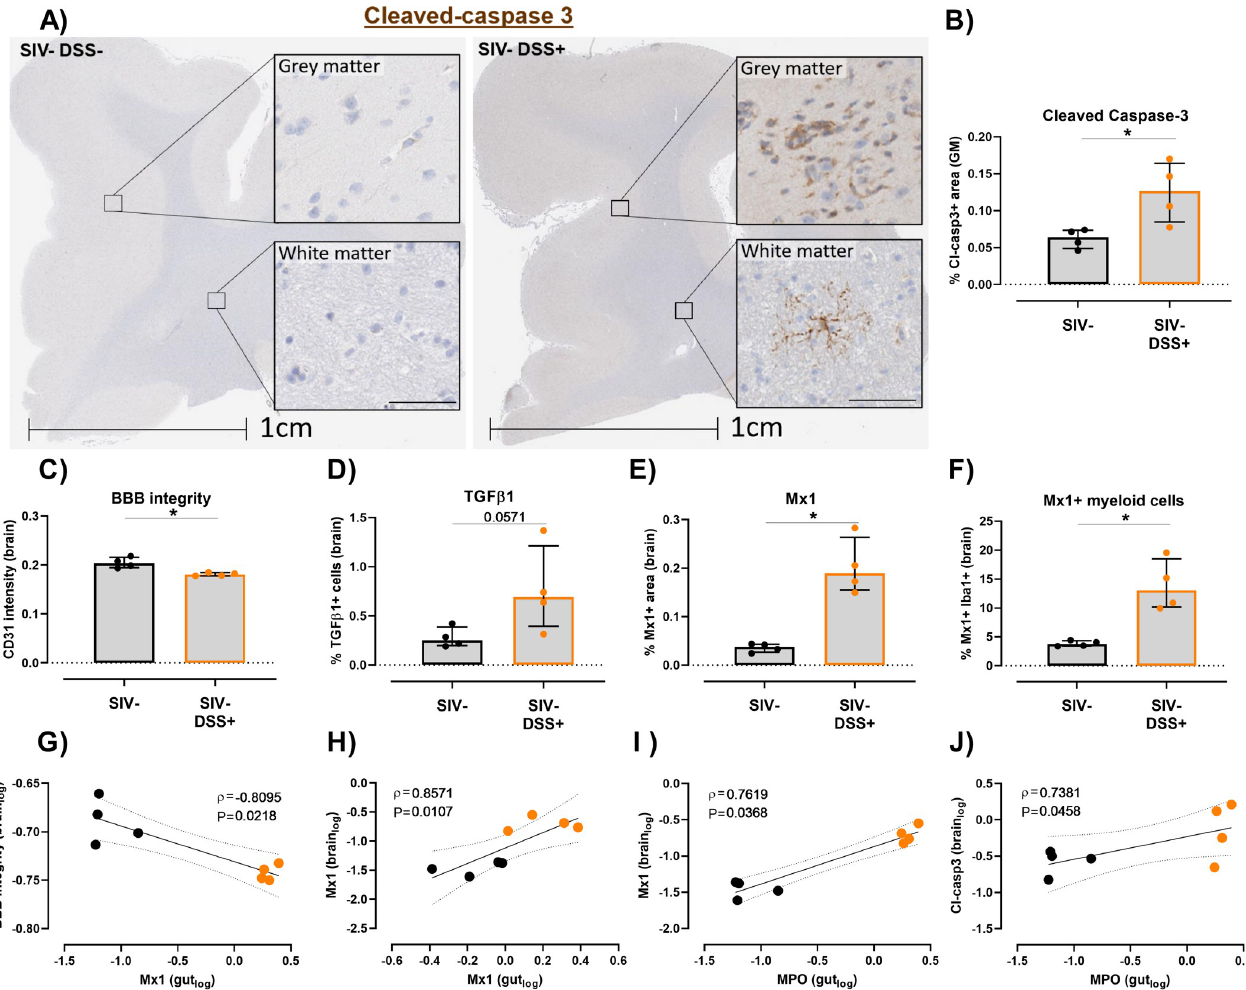
Fig 7. Gut damage induces cellular activation in the frontal cortex of the brain in the absence of viral infection. (A) Representative images of cleaved caspase-3 (Cl-casp3) staining in the grey and white matter of the frontal cortex of SIV uninfected (black; n = 4) or SIV-uninfected DSS-treated (SIV-DSS+; orange; n = 4) rhesus macaques. Scale bars: 1 cm (overview) and 50 μ m (insert). (B) Percentage area of Cl-casp3+ tissue in grey matter. Comparison of levels of (C) blood brain barrier (BBB) integrity (CD31 intensity), (D) TGF- β 1, (E) Mx1 or (F) % Iba1+ Mx1+ as a percentage of Iba1+ cells between DSS untreated (n = 4) and treated animals (n = 4). Comparisons made using Mann-Whitney U test, median and interquartile ranges shown ( * P < 0.05). (G-J) Correlation of immune activation markers in gut and brain tissue. Spearman Rho and P values